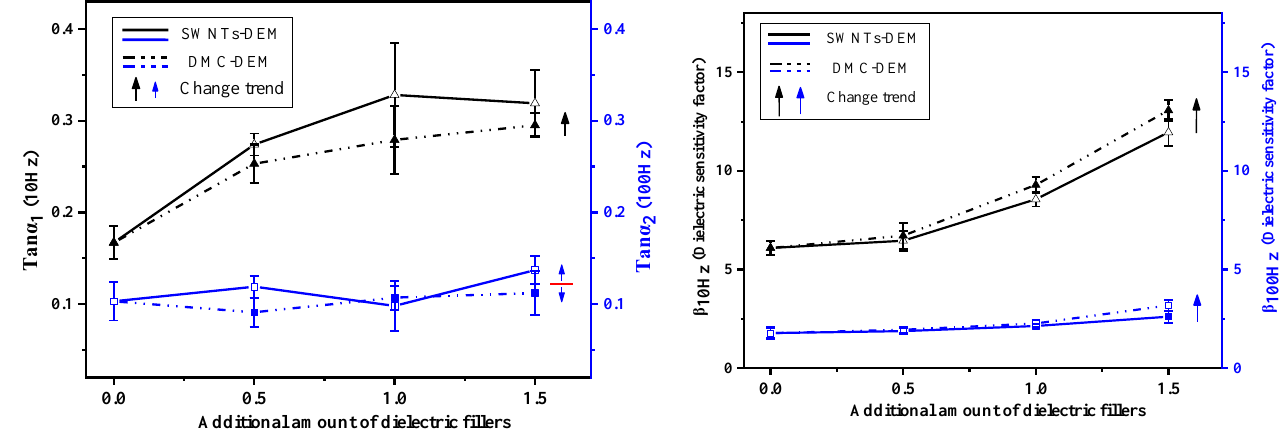
Figure 8. Comparison and change trend of dielectric properties of polyurethane fiber membrane.